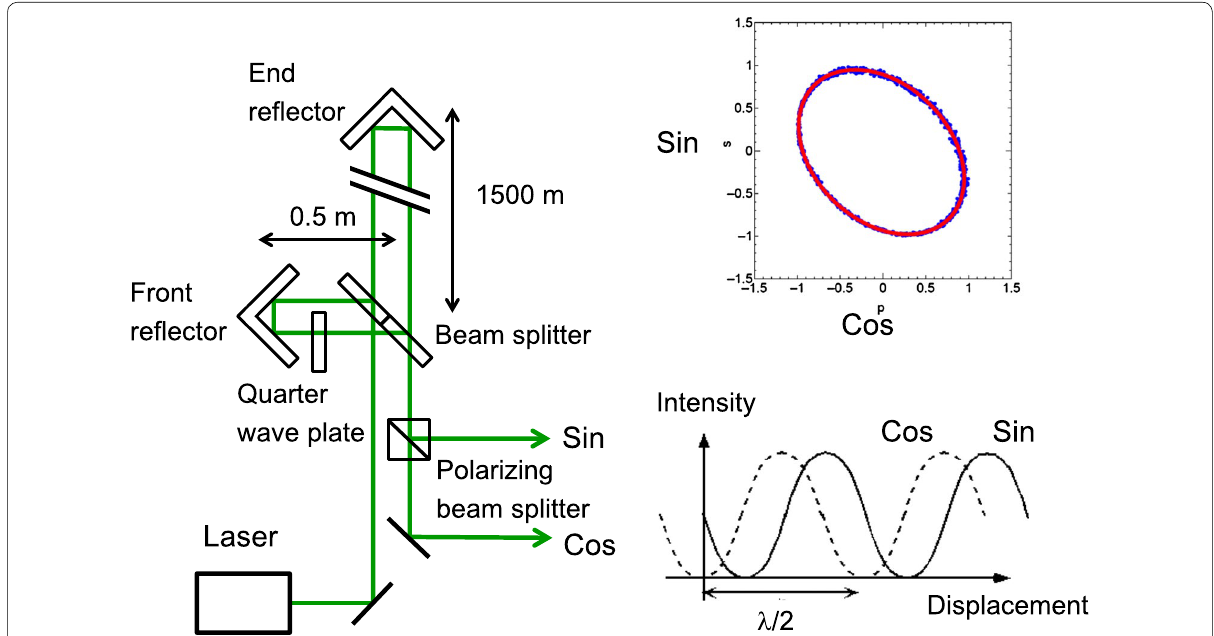
Fig. 3 Quadrature interferometer used in the 1500-m laser strainmeter ( left ). A quarter-wave plate inserted in the interferometer produces a 90° phase shift between the horizontal and vertical polarizations. As a result, the intensities of the interference beams for both polarizations separated by the polarizing beam splitter complementarily change as sine and cosine ( bottom right ). By normalizing the observed elliptic Lissajous curve ( top right ) into a circular one, mirror motion can be determined from the phase